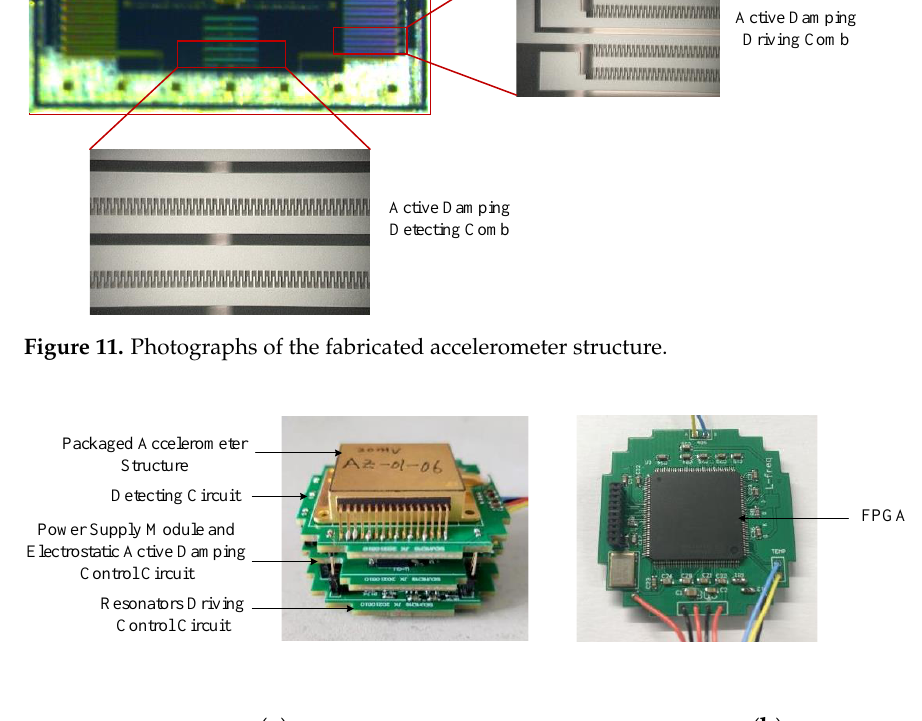
Figure 12. Photographs of the micromachined silicon resonant accelerometer: ( a ) packaged accelerometer structure and peripheral circuitry and ( b ) frequency measurement module.